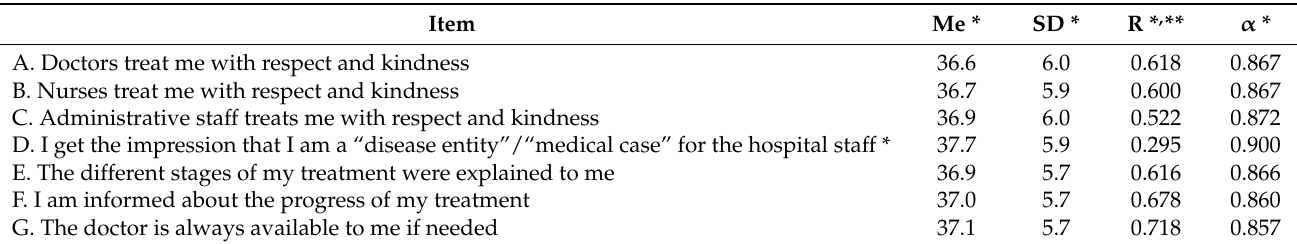
Table 1. Analysis of the item reliability of the Patient Care Quality Assessment (PCQA)